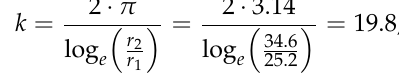
Figure 2. Measurement setup of microwave transmission and reflection from the coated fabric. TA denotes transmitting and RA—receiving antennas. It is seen that the measured sample of the fabric is surrounded with absorber sheets preventing for the diffracted wave directly get to the receiving antenna. We used tuneable microwave generator as a microwave source. Continuous wave signal was passed to the transmitting antenna. Transmitted and reflected power was measured using average power sensors from Rhode & Schwarz (Fleet, Hampshire, UK) NRP-Z24. The maximum absolute uncertainty for power measurements for such a sensor is 0.222 dB, which is equal to ±5.24 %. The receiving antenna measuring reflection was positioned near the transmitting one. Direct coupling between them was less than − 30 dB. The measured transmitted power P t with an object under the test was normalized by the power P t0 measured in the absence of it. Therefore, the transmittance can be expressed in the following way: 0 tt PP T = (3) Results of transmittance are presented in a form of EMR shielding effectiveness SE expressed in decibels: